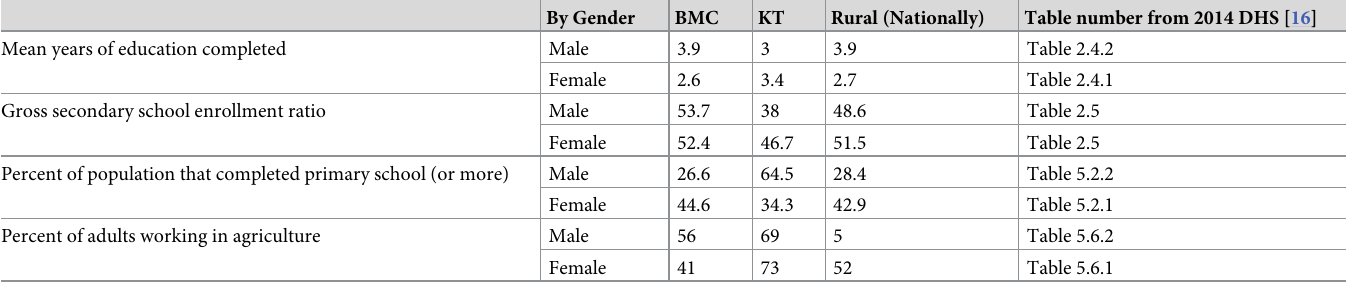
Table 1. Overview of education and employment information for the study provinces and rural